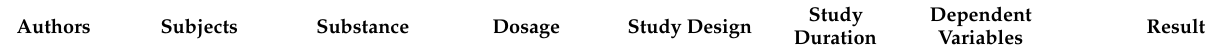
Table 1. Summary of clinical trials included in this review ( n =